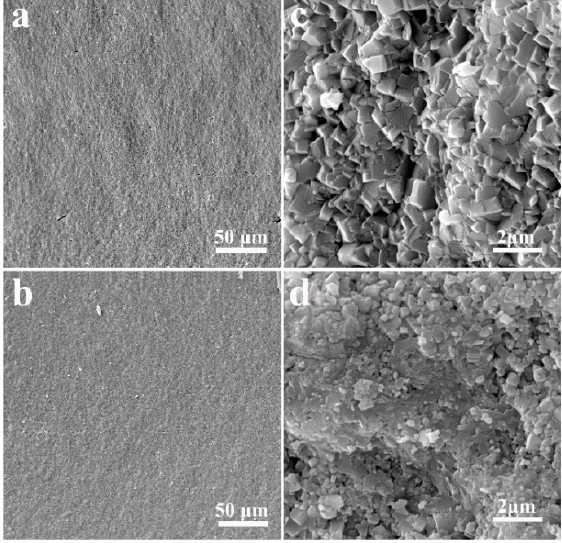
Figure 4. Cross-sectional SEM images of ( a , c ) conventionally sintered LAGP pellets and ( b , d ) SPS-sintered LAGP pellets.